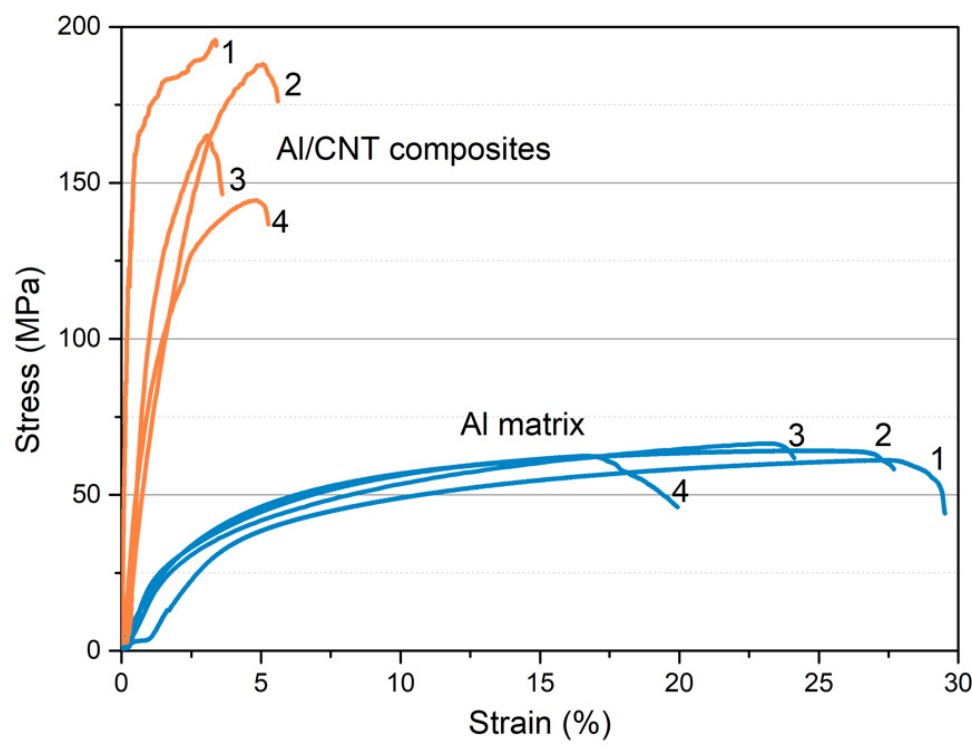
Figure 6. Tensile curves of tensile specimens of aluminum matrix and the nanocomposites produced under the same conditions.